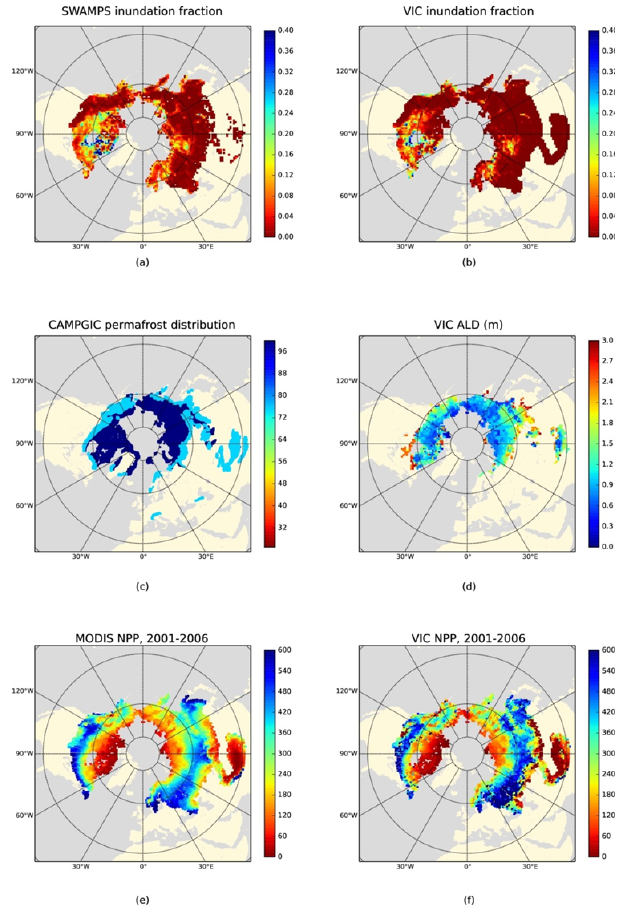
Figure 2. Observed and simulated factors relevant to wetland methane emissions over the study domain: (a) observed June–July– August average (JJA) inundated area fraction over 2002–2010 from SWAMPS (Schroeder et al., 2010); (b) simulated JJA inundated area fraction over 1948–2006; (c) observed permafrost distribution from CAMPGIC (Brown et al., 2014; dark blue: continuous per- mafrost; light blue: discontinuous permafrost); (d) simulated max- imum active layer depth (ALD) over 1948–2006; (e) observed JJA net primary productivity (NPP) over 2002–2010 (Running et al., 2004); (f) simulated JJA LAI over 1948–2006.